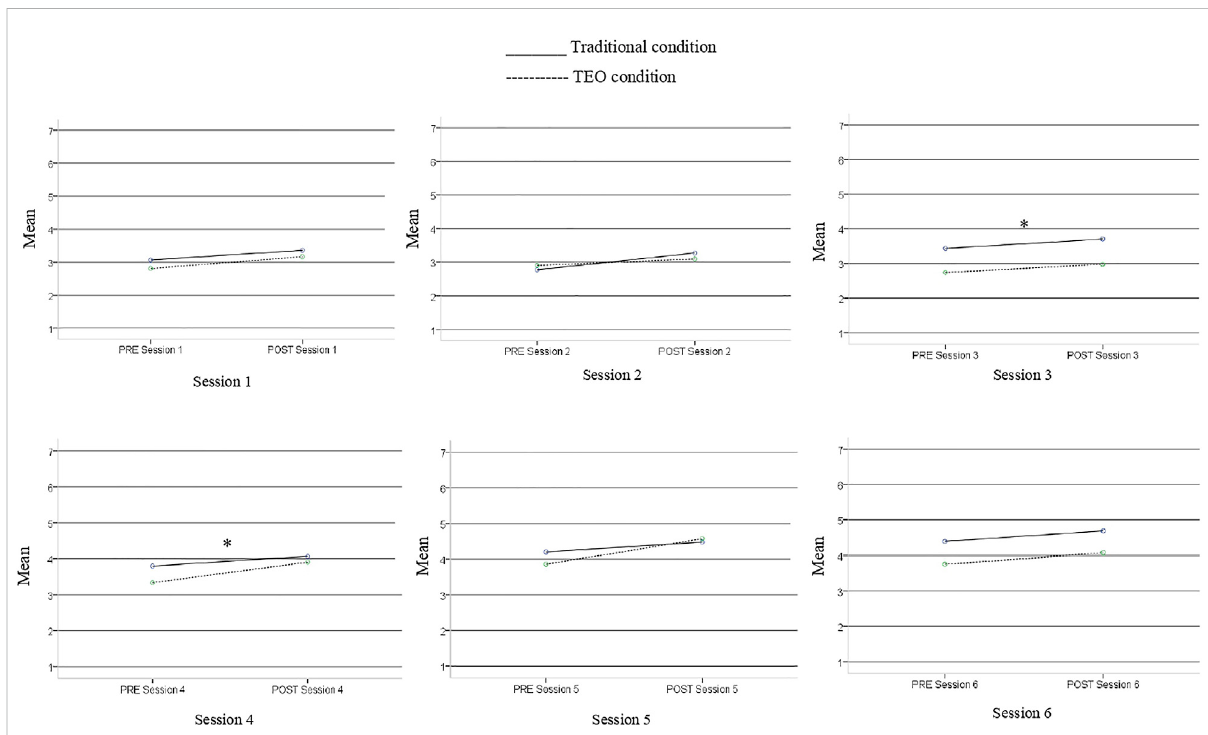
FIGURE 4 Positive emotion for both conditions assessed before and after each homework assignment session. *Signi fi cant change compared to the fi rst